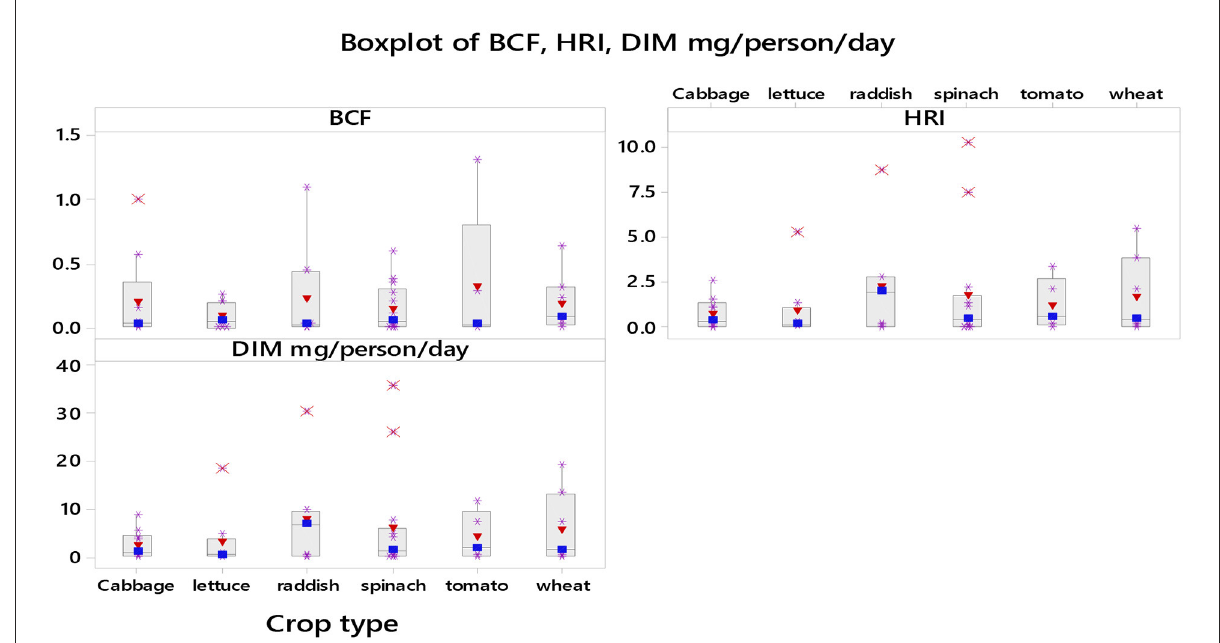
FIGURE9 Plant concentration factor (PCF/BCF) (The maximum PCF value (5) for one study is not included in this graph) and daily intake of lead (DIM) and its health risk index